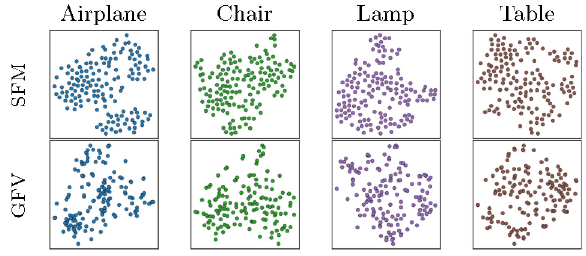
Fig. 8 Compared to GFV used in Ref. [29], the feature embedding of the learned SFM is more uniformly